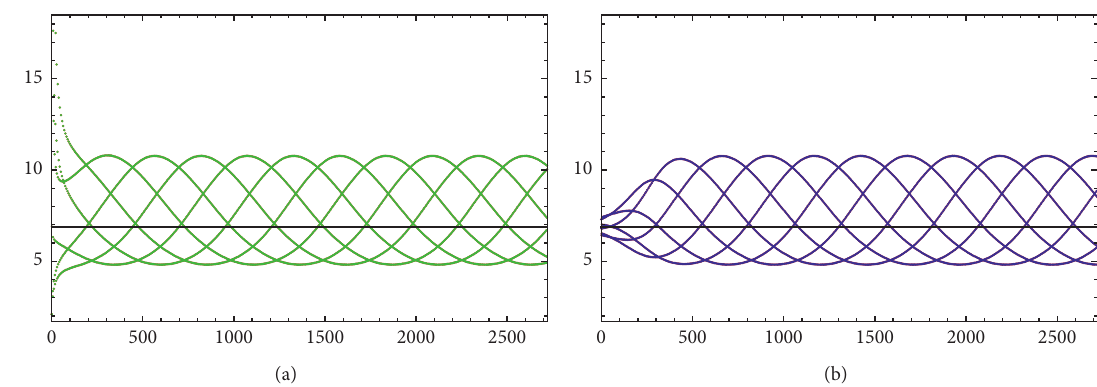
Figure 3: Orbits with initial conditions: ( x